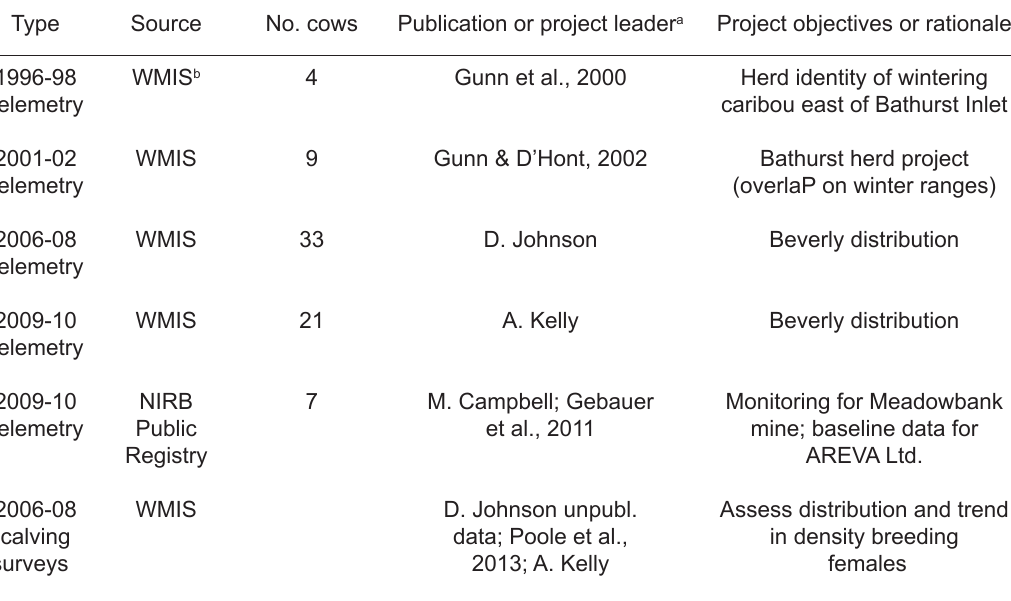
Table 1. Sources and type of data used in